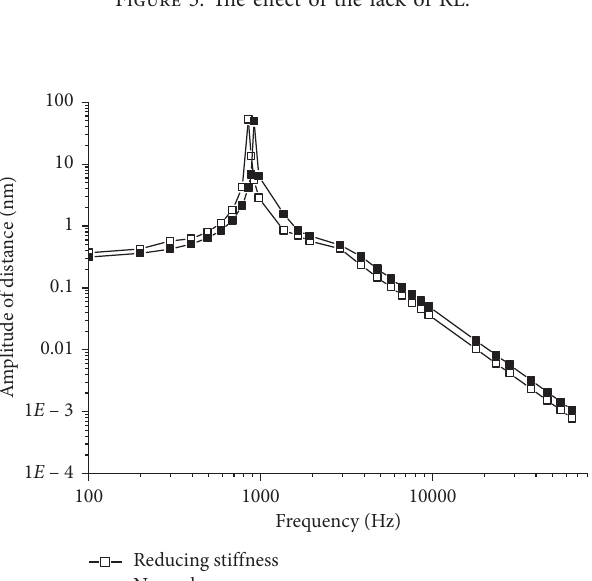
Figure 5: The effect of the lack of RL.